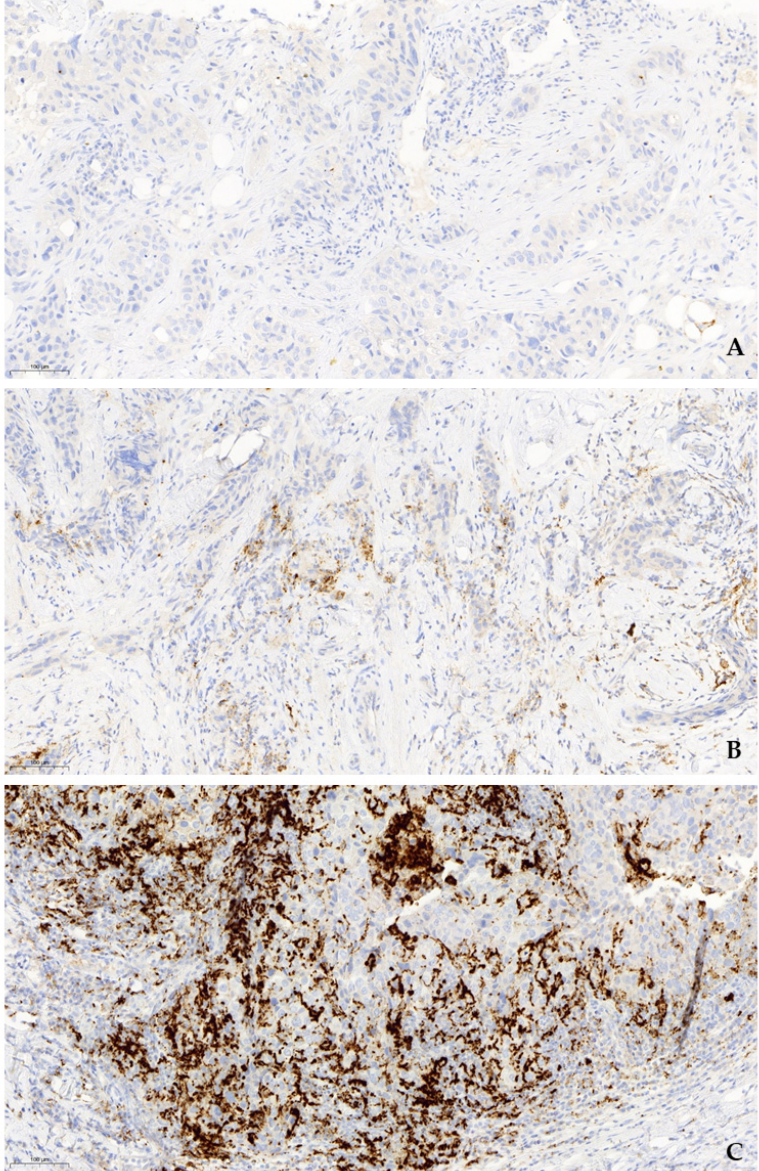
Figure 1. PD-L1-positivity of immune cells shows membranous and cytoplasmic staining of various intensity. A punctate or granular pattern of cytoplasmic staining is typically observed with SP142 assay (IHC PD-L1 SP142, 15× magnification). ( A ). PD-L1-negative (IC < 1%), ( B ). PD-L1- positive (IC ≥ 1%, low expression), ( C ). PD-L1-positive (IC ≥ 1%, high expression).